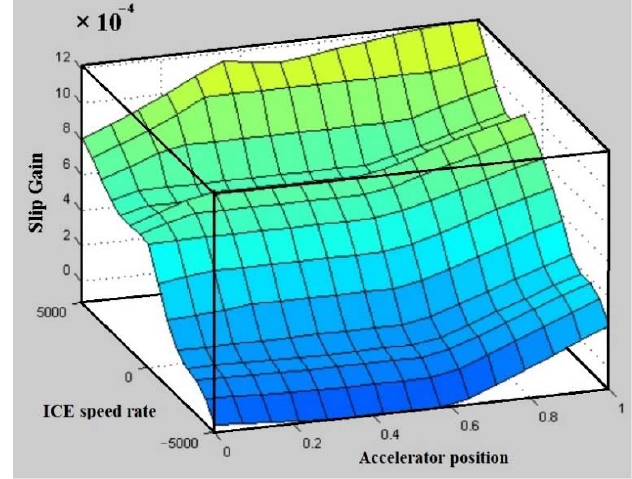
Figure 7. Slipping gain, ICE speed rate, and acceleration position.